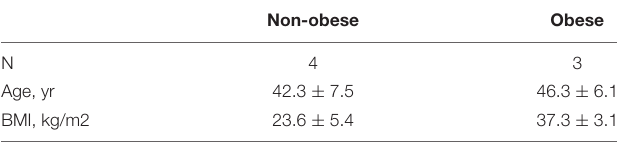
TABLE 1 | Characteristics of non-obese and obese lung epithelial cells. Non-obese Obese